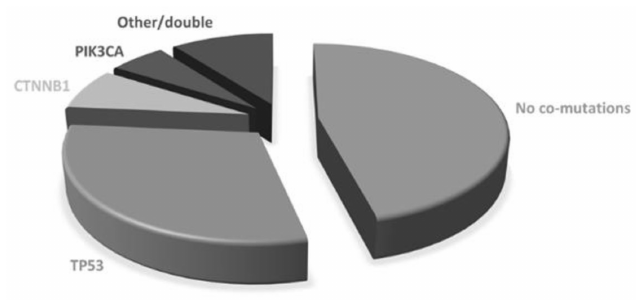
Figure 1. Baseline